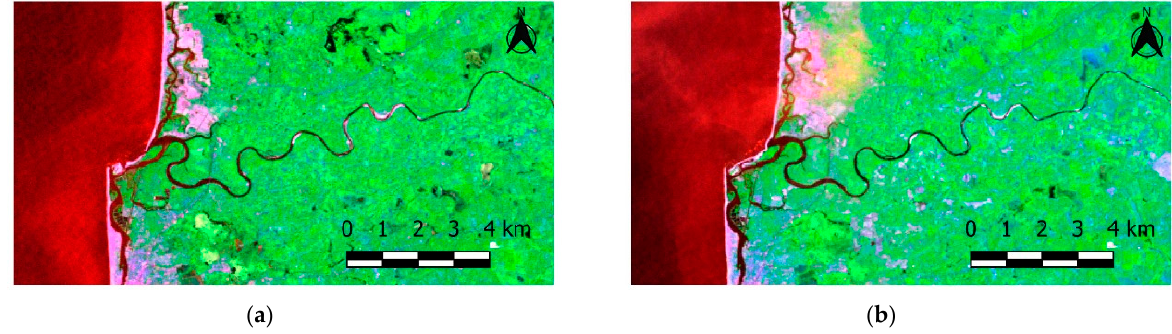
Figure 3. Illustrative maps of meandering features of the Deduru Oya using Landsat data: ( a ) for 2008—Landsat false color composite bands on LT05_L1TP_142055_20081229_20200828_02_T1_B (1, 4, 7); ( b ) for 2010—Landsat false color composite bands on